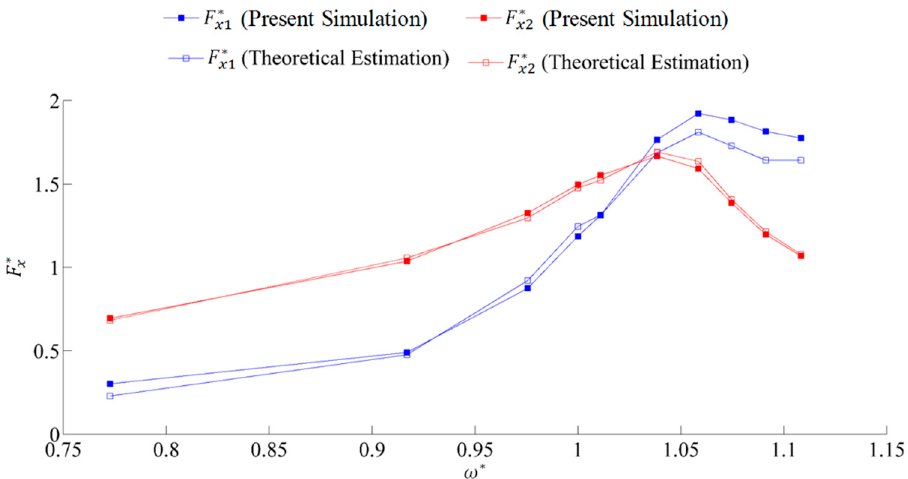
Figure 23. The variation tendencies of the horizontal force amplitudes are well predicted by the theoretical estimations based on Equations (30) and (31) ( B ∗ g = theoretical estimations based on Equations (30) and (31) ( 𝐵 (cid:3034)∗ = 0.25 ).